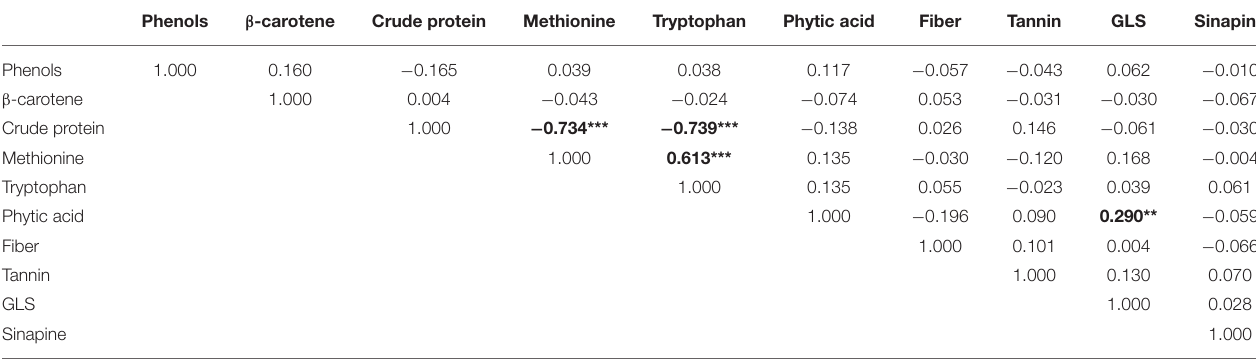
TABLE 2 | Pearson correlation coefficients for seed meal quality traits. Phenols β -carotene Crude protein Methionine Tryptophan Phytic acid Fiber Tannin GLS Sinapine Phenols 1.000 0.160 − 0.165 0.039 Crude protein Methionine 1.000